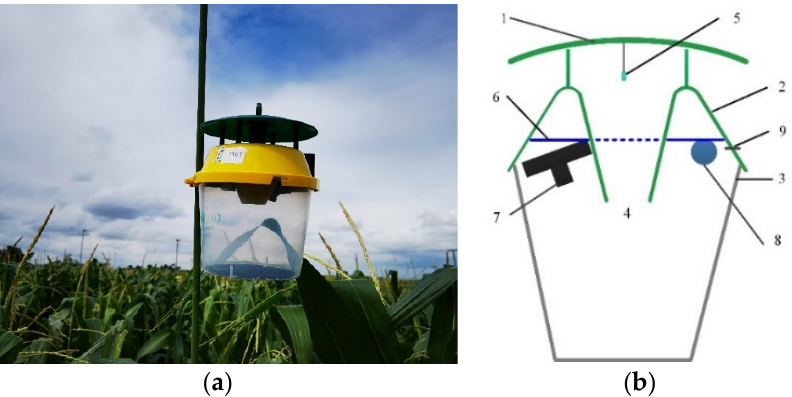
Figure 3. Low-power monitoring device for pests captured using sex pheromone lures. ( a ) Low- power monitoring device for S. frugiperda. ( b ) Schematic diagram of the monitoring device. 1: rain cover; 2: funnel; 3: collecting bucket; 4; pest entrance; 5: sex pheromone lure; 6: circuit board; 7: camera; 8: battery; 9: solar panel.